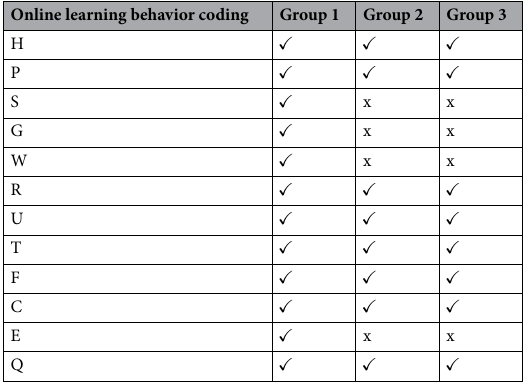
Online learning behavior